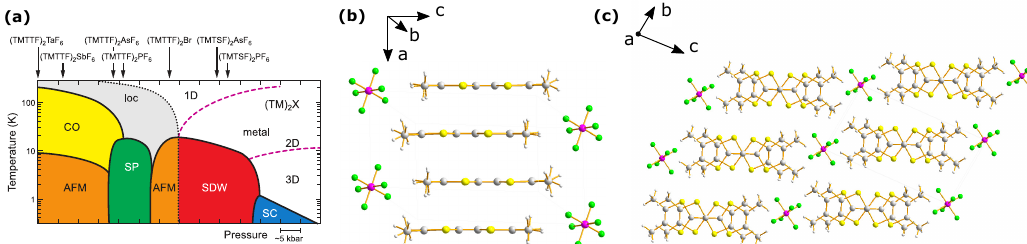
Figure 1. ( a ) The generic phase diagram of the tetramethyltetrathiafulvalene (TMTTF) and tetramethyltetraselenafulvalene (TMTSF) salts with centrosymmetric anions, as first suggested by Jérome [7] and further refined by other groups [2]. The position can be tuned either by external physical pressure or by chemical pressure via substituting the anion. The arrows indicate the ambient pressure position of the particular compounds with different anions. Decreasing the anion size corresponds to increasing pressure upon which the properties become more metallic and less one-dimensional. The full and dashed lines indicate phase transitions and crossovers, respectively. The various terms are shortened as follows: CO charge order, loc charge localization, SP spin-Peierls, AFM antiferromagnet, SDW spin density wave and SC superconductivity; ( b ) Crystal structure of (TMTTF) 2 PF 6 [8] illustrating the stacking of the TMTTF molecules and the anions along the a -direction and, ( c ) in the bc -plane showing the separation of the TMTTF stacks by